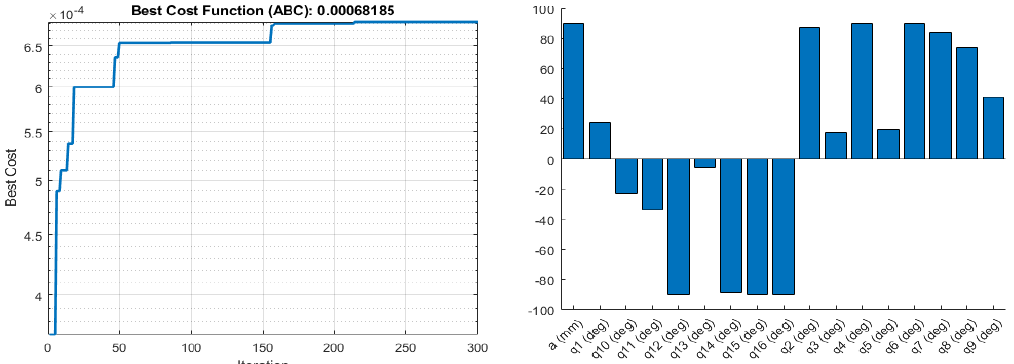
Figure 8. Objective function values ( left ), and the corresponding optimised joint parameters ( right ) for the best objective function value obtained by ABC for the ∆H manipulability measure.